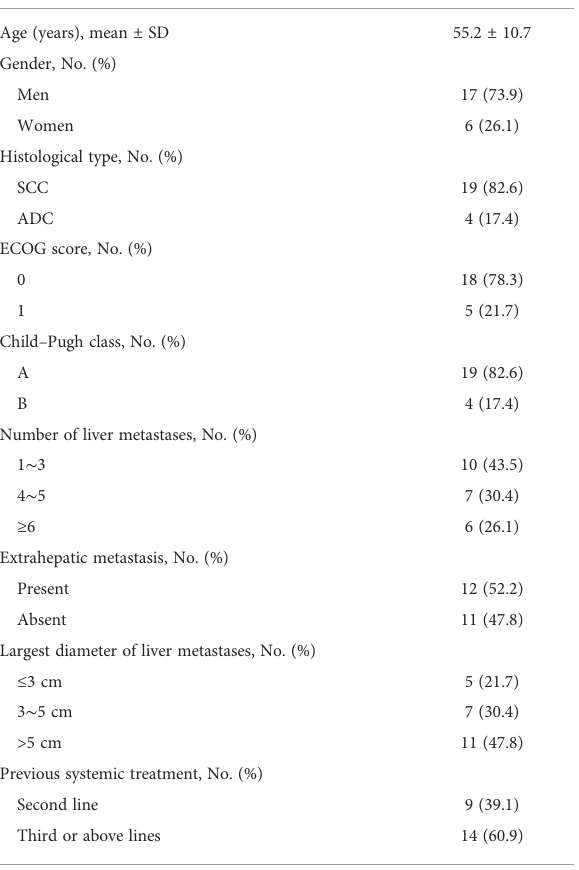
TABLE 1 Clinical characteristics.